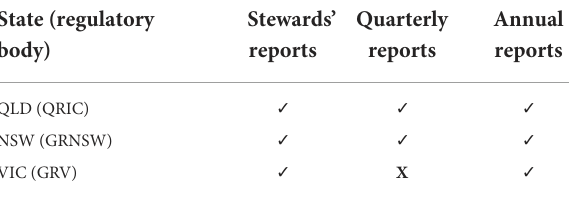
TABLE 1 Availability of report types for QLD, NSW and VIC between 2016 and